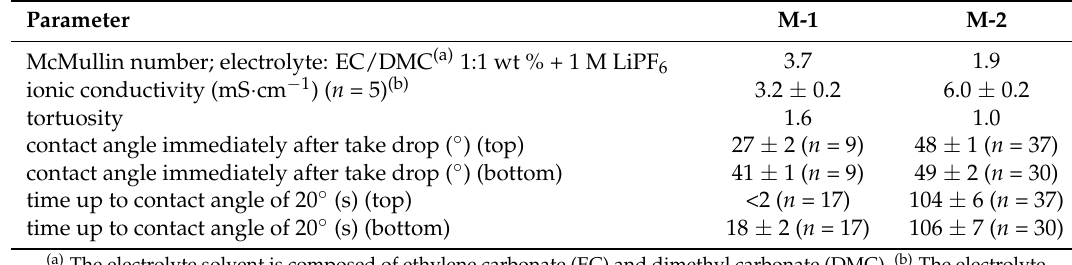
Table 3. Characteristics of membrane–solvent-interactions of both micron-sized pored membranes. Provided are the mean value and the standard error (SE) of the mean value from n individual